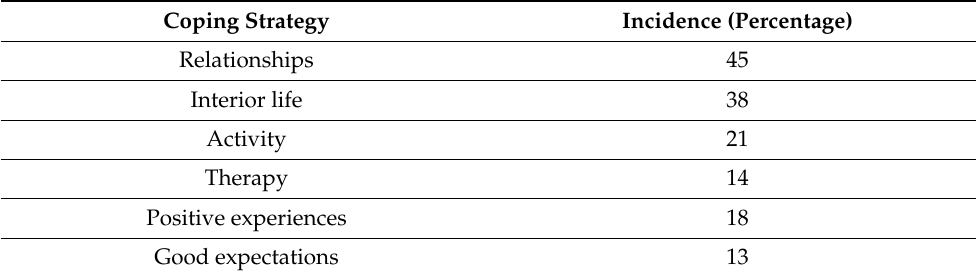
Table 4. Main coping strategies ranked by incidence. Coping Strategy Incidence (Percentage) Relationships 45 Interior